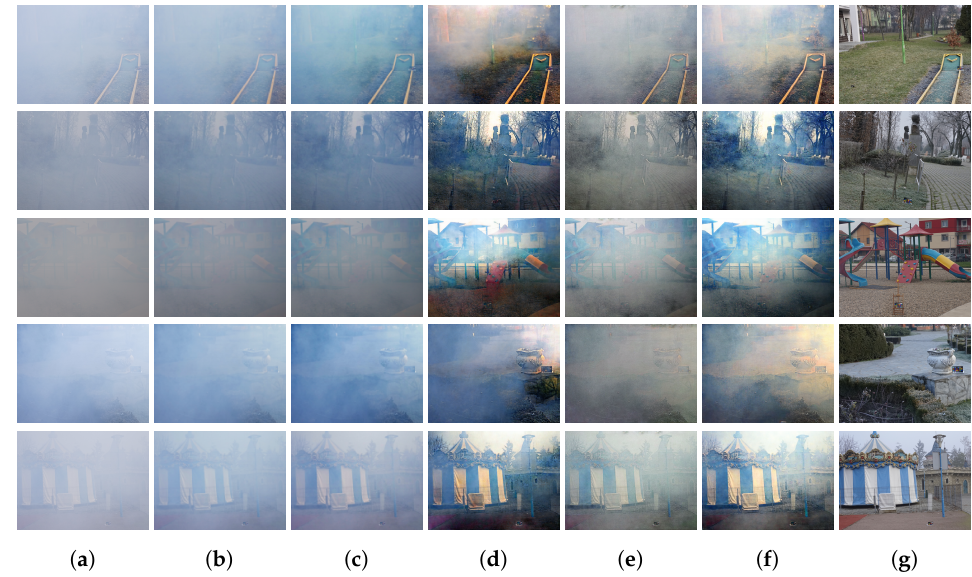
Figure 9. Qualitative comparison of defogging on the Denze-Haze dataset [12]. ( a ) Foggy images, ( b ) defogging by [2], ( c ) defogging by [3], ( d ) pix2pix [34], ( e ) Cycle–Dehaze [7], ( f ) CurL-Defog (our approach), ( g ) ground-truth image. Images are better viewed if enlarged on a computer monitor.